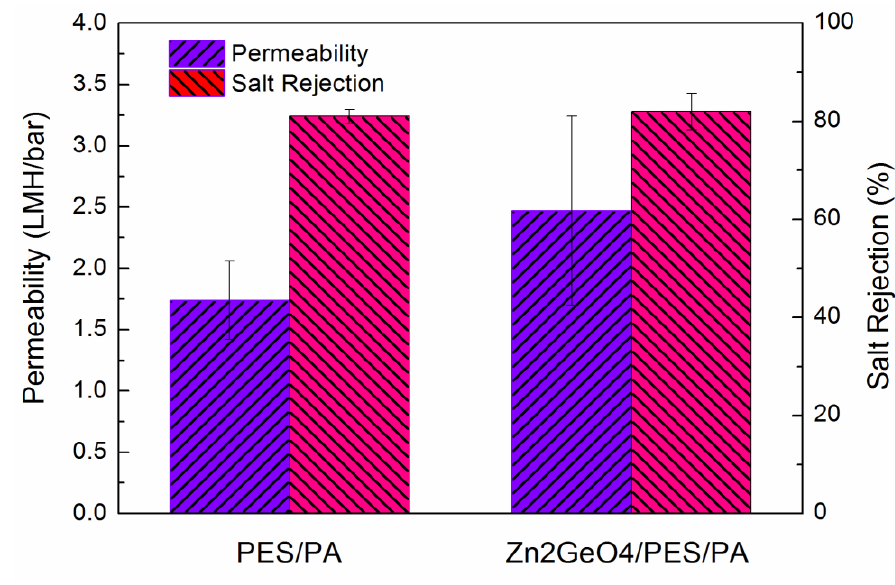
Figure 3. Water permeability and NaCl rejection of pristine membrane and Zn 2 GeO 4 /PES/PA forward osmosis (FO) membrane in reverse osmosis (RO) mode. Table 2. Ratio of J w /J s at different concentration of NaCl, K m , S , 𝜏 of control and modified membranes. Sample/ DS 0.5 1.0 2.0 K m Concentration (M) Control 3.8 3.8 3.5 2.2 352 3.56 Zn GeO /PES/PA 6.4 12.1 5.3 3.4 540 6.58 2 4